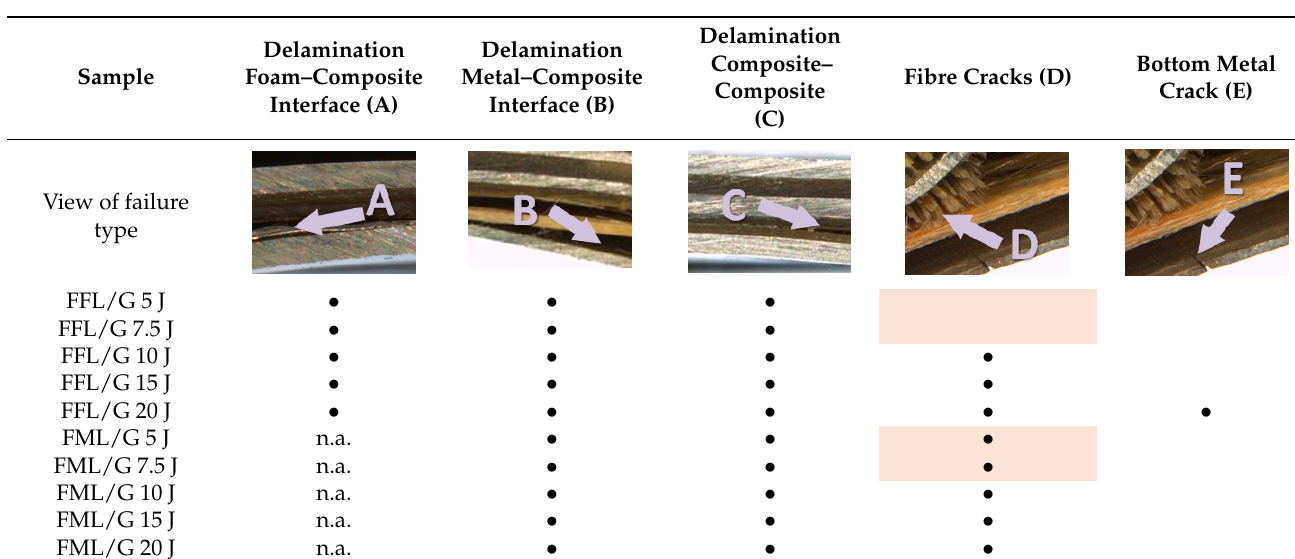
Table 3. Types of failure in glass–based laminates.